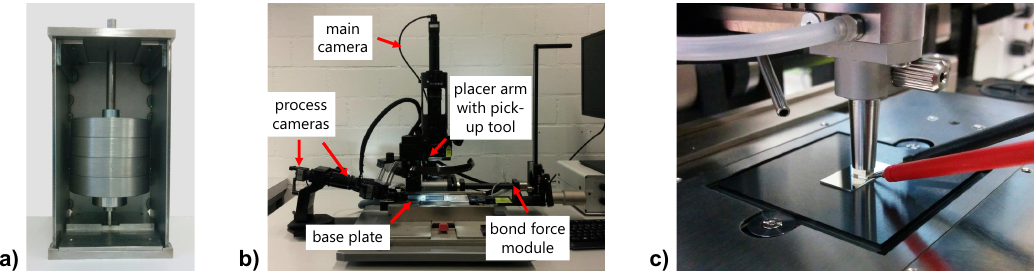
Figure A1. Experimental devices used for reactive joining: ( a ) custom-made apparatus with adjustable weights for uniaxial pressure application (suitable for performing joining experiments in a vacuum chamber, see [10]). The substrates and foils are aligned with masks; ( b ) flip-chip bonder for precise specimen assembly and uniaxial pressure application; ( c ) close-up photograph showing the assembled specimen on the flip-chip bonder and the electrodes positioned on the RF for foil ignition. Both devices produced joints of the same quality. An example video for reactive joining using a manual flip-chip bonder is online available under [30].